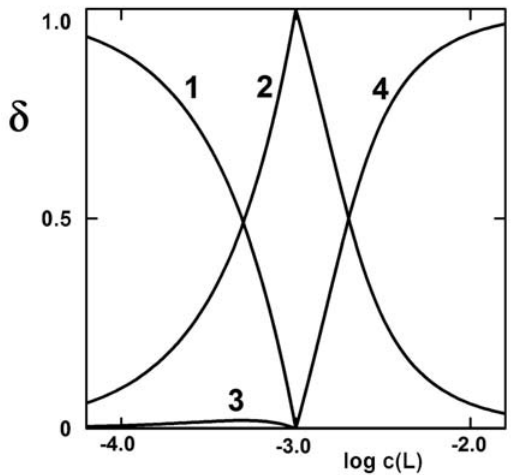
Figure 3. Distribution diagram of hydrogen cation in the equili- brium nitrobenzene phase of the water–HNO –Eu 3+ (microa- 3 mounts)–nitrobenzene– N,N,N’,N’ -tetrabutyl-1,10-phenanthroline- 2,9-dicarboxamide (L)– H + B – extraction system in the forms of H + , H L 2+ , and HL + ; c(HNO ) = 0.05 mol/L, c = 0.0025 mol/L. 2 2 3 B ]/ c(H + ) ]/ c(H + ) , 2 δ (HL + ) = [ HL + , 1 δ (H + ) = [ H + org org org org